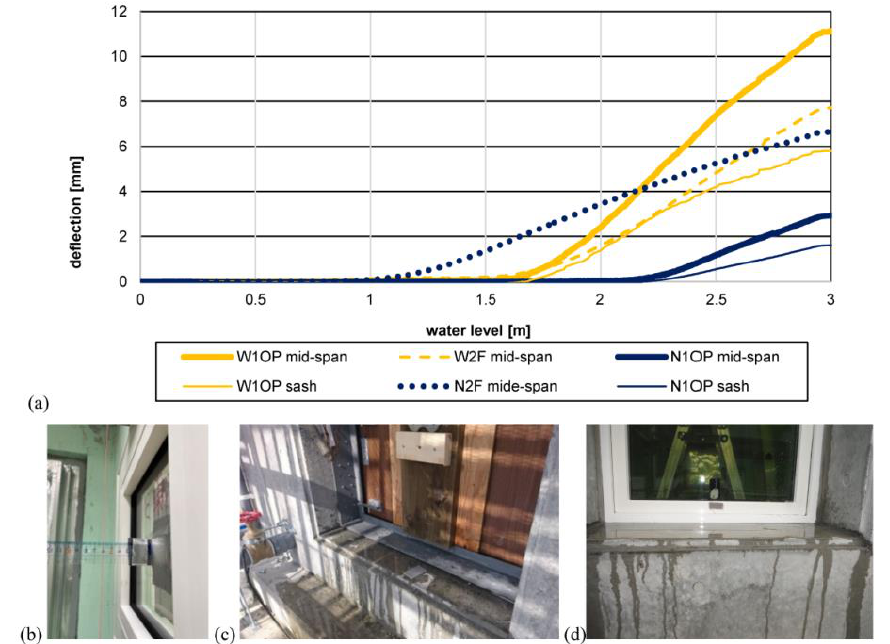
Figure 5. Hydrostatic pressure test: ( a ) relations between water depths and deflection of the exterior pane of the windows at different points, ( b ) ruler used for the measurement, water leak from the entrance door ( c ) and from the west operable window ( d ). Table 1. Maximum deflection of the interior pane of the glazed windows. (mm) W1OP W2F N1OP sash